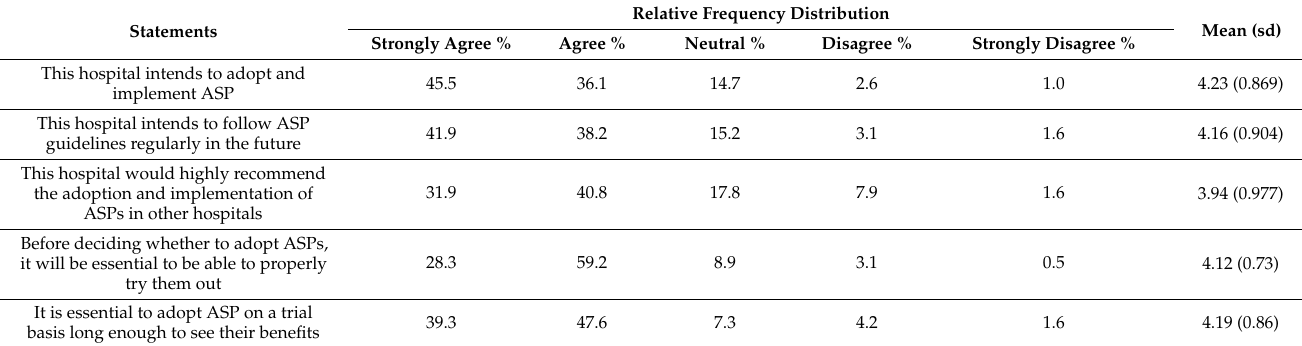
Table 8. Hospitals’ intention to adopt and implement ASPs ( n =